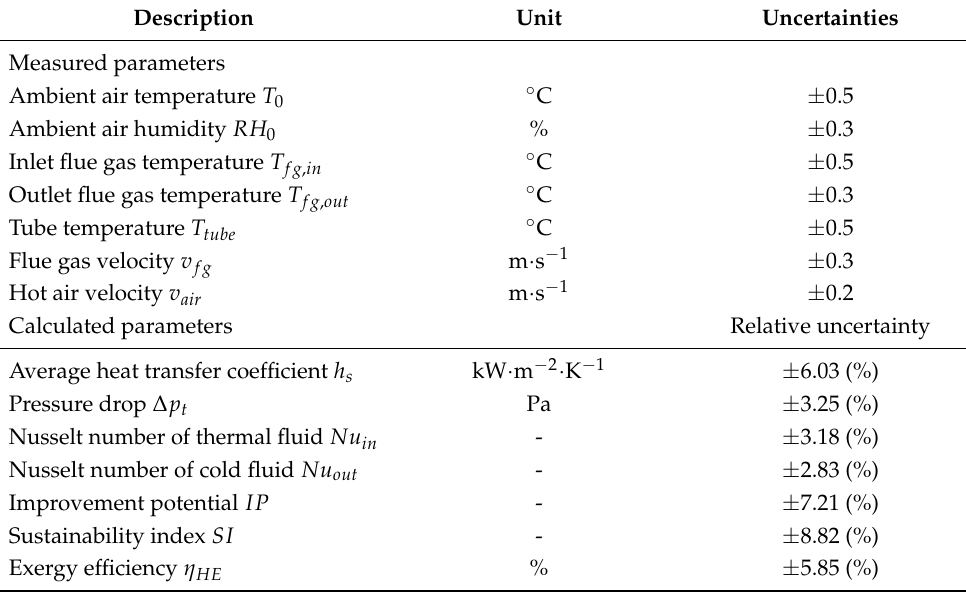
Table 4. Uncertainties of the measured parameters and calculated